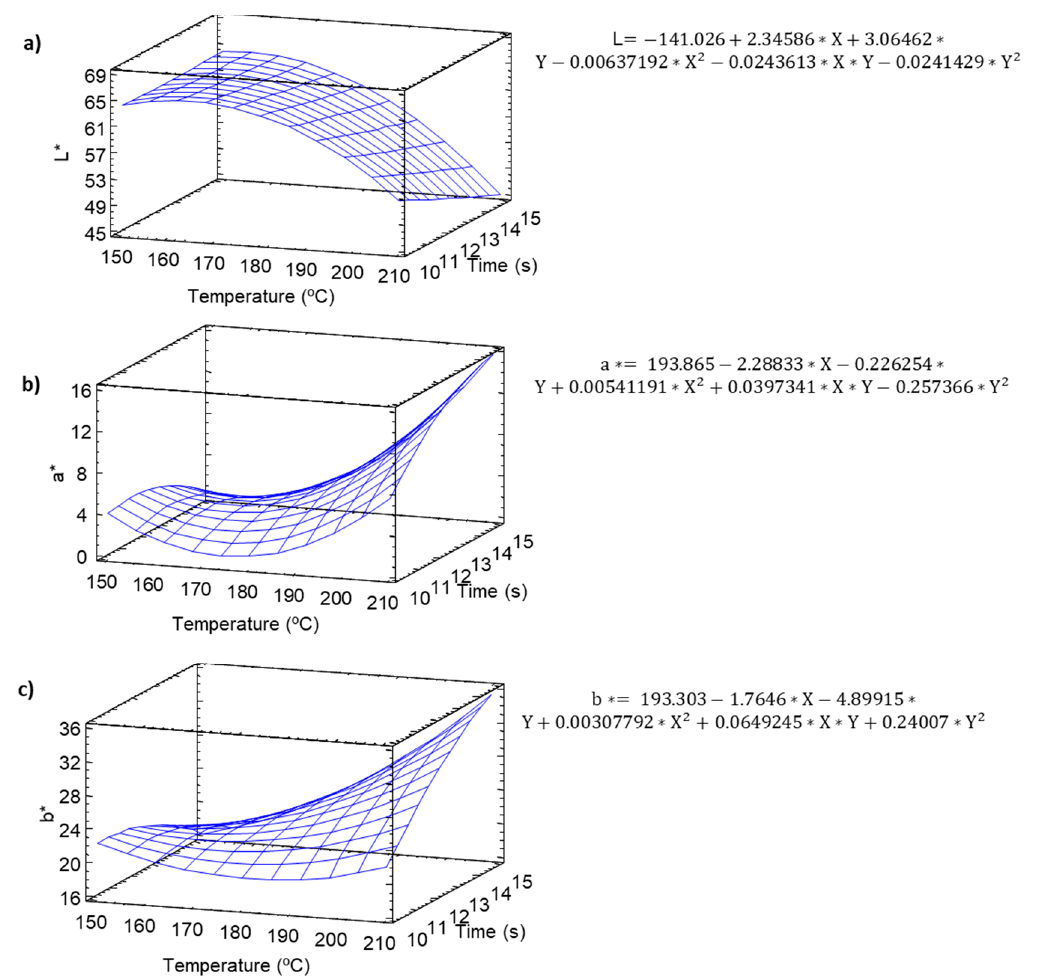
Figure 8. Color variation in the snacks. Equations and modeled variation in the effect of temperature and time on the CIELab parameters: ( a ) luminosity, ( b ) a* (green-red), ( c ) b* (blue-yellow).